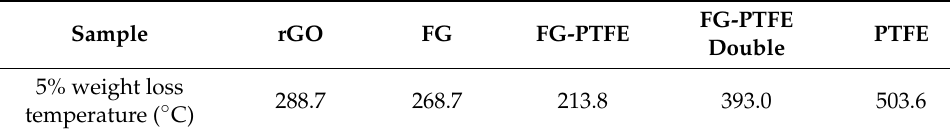
Figure 4. TGA and UV-Vis absorption curves. ( a ) TGA curves of different samples. ( b ) UN-Vis absorption curves of different samples. Table 1. The 5% weight loss temperatures of different